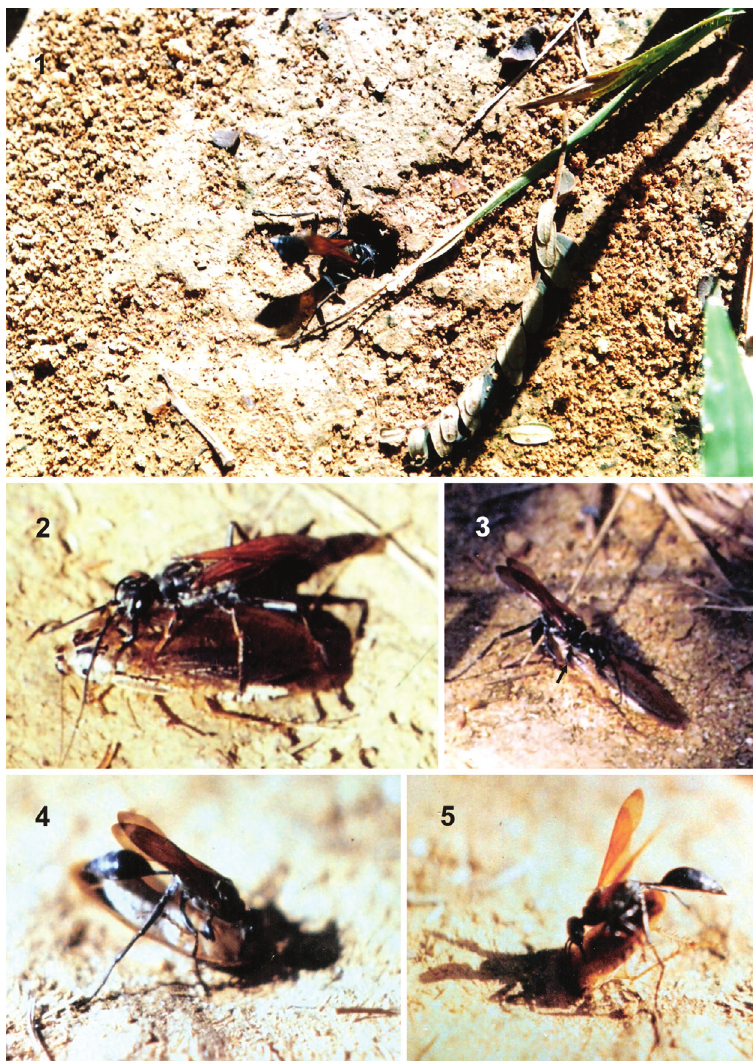
Figures 1–5. Nesting behaviour of Penepodium luteipenne 1 Digging of the nest, the accumulated lose earth around the nest entrance is the earth excavated from the burrow 2 stinging of the prey 3 oviposition (setae in the wasp’s front leg) 4 placement of the prey into the nest 5 female pushing a prey stuck in the nest entrance, using both the front and mid legs, and the opened Brood parasitism in open nests Brood parasitism in open nests was observed twice. In the first case the female entered the nest of another female while she was absent and found prey items. She reacted quickly, moving her body and antennae, and performed the following behavioural sequence: (1) grasped one cockroach with her mandibles, (2) pulled the cockroach